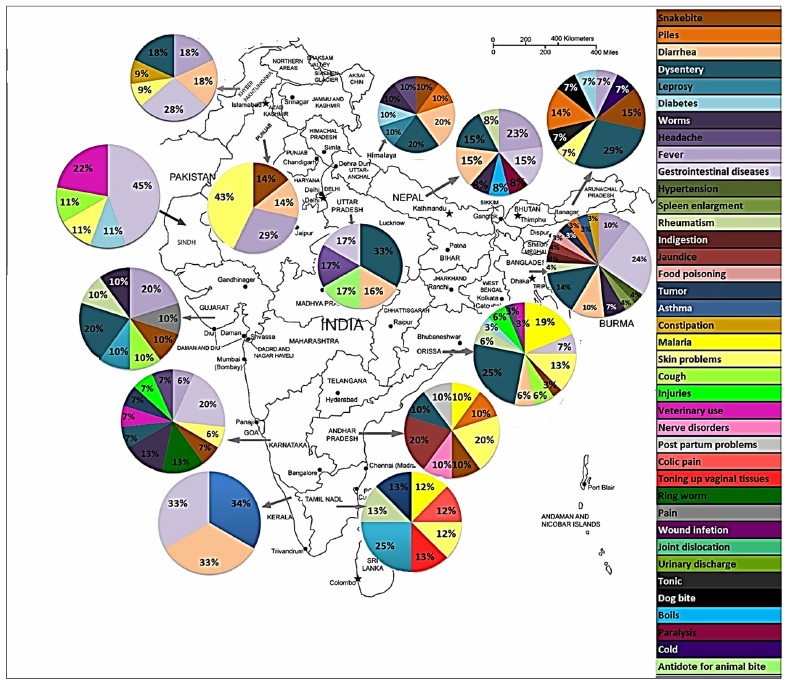
Figure 2. Medicinal use of H. pubescens in India, Pakistan, Bangladesh and Nepal.